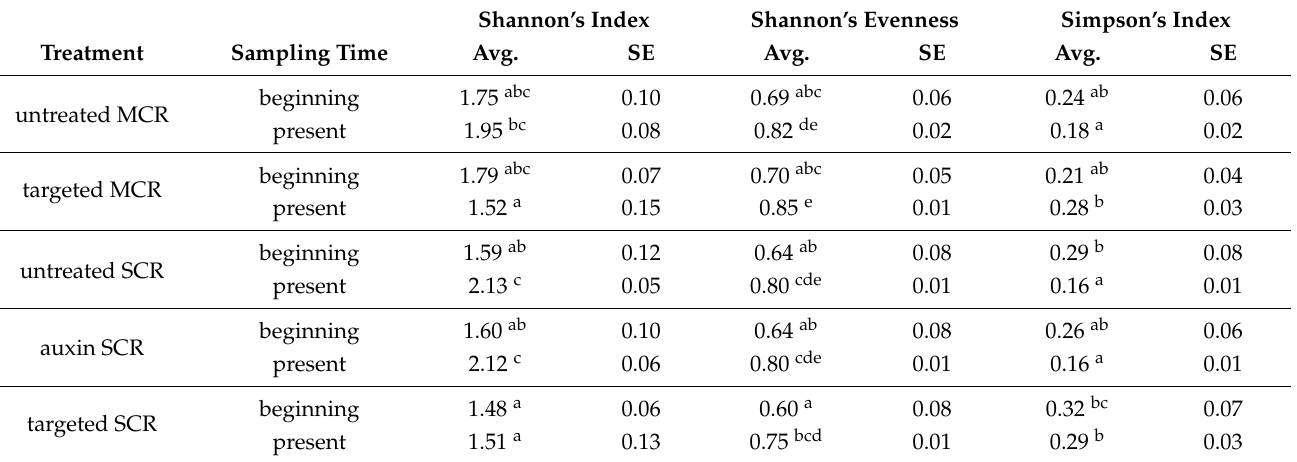
Table 2. Species diversity of weed community expressed by diversity indices—the situations in winter wheat at the trial beginning (1972) and present (2013–2016). The average values of indices (Avg.) ± standard error (SE) include both localities and four replications for each treatment. The averages marked by the same letter in individual columns did not significantly differ at α = 0.05 (Scheffe’s test). Shannon’s Index Shannon’s Evenness Simpson’s Index